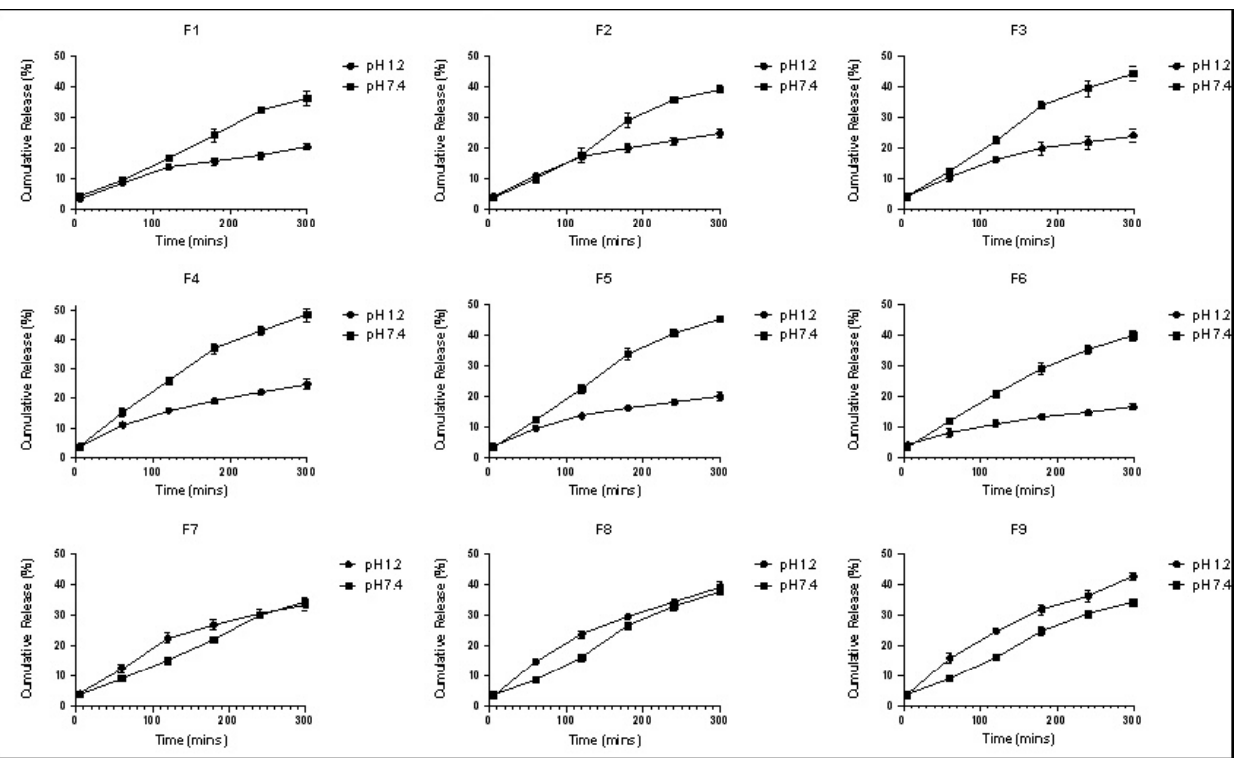
Figure 4. The release profiles of the polymeric formulations (mean ± SD, n = 3) at pH 1.2 and pH 7.4. Table 6. R 2 , n , and k obtained from fitting the release data to the Korsmeyer–Peppas model.